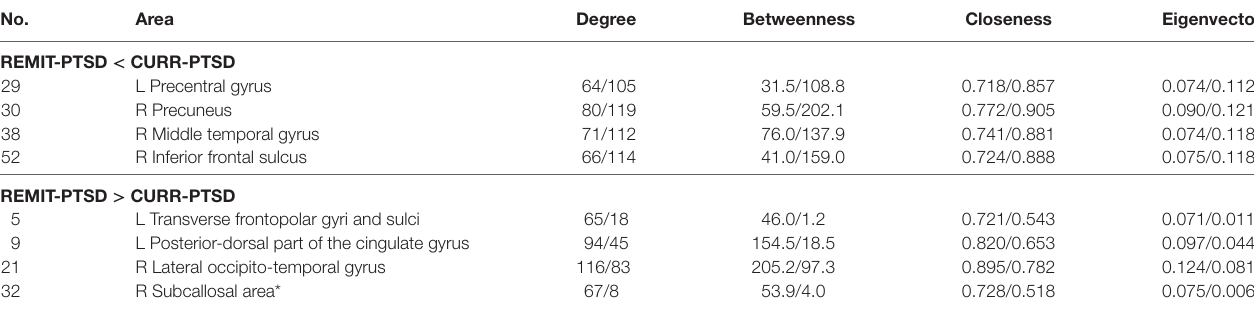
TaBle 3 | Centrality between-group comparisons: REMIT-PTSD (lifetime but no current PTSD group) versus CURR-PTSD (current PTSD group).